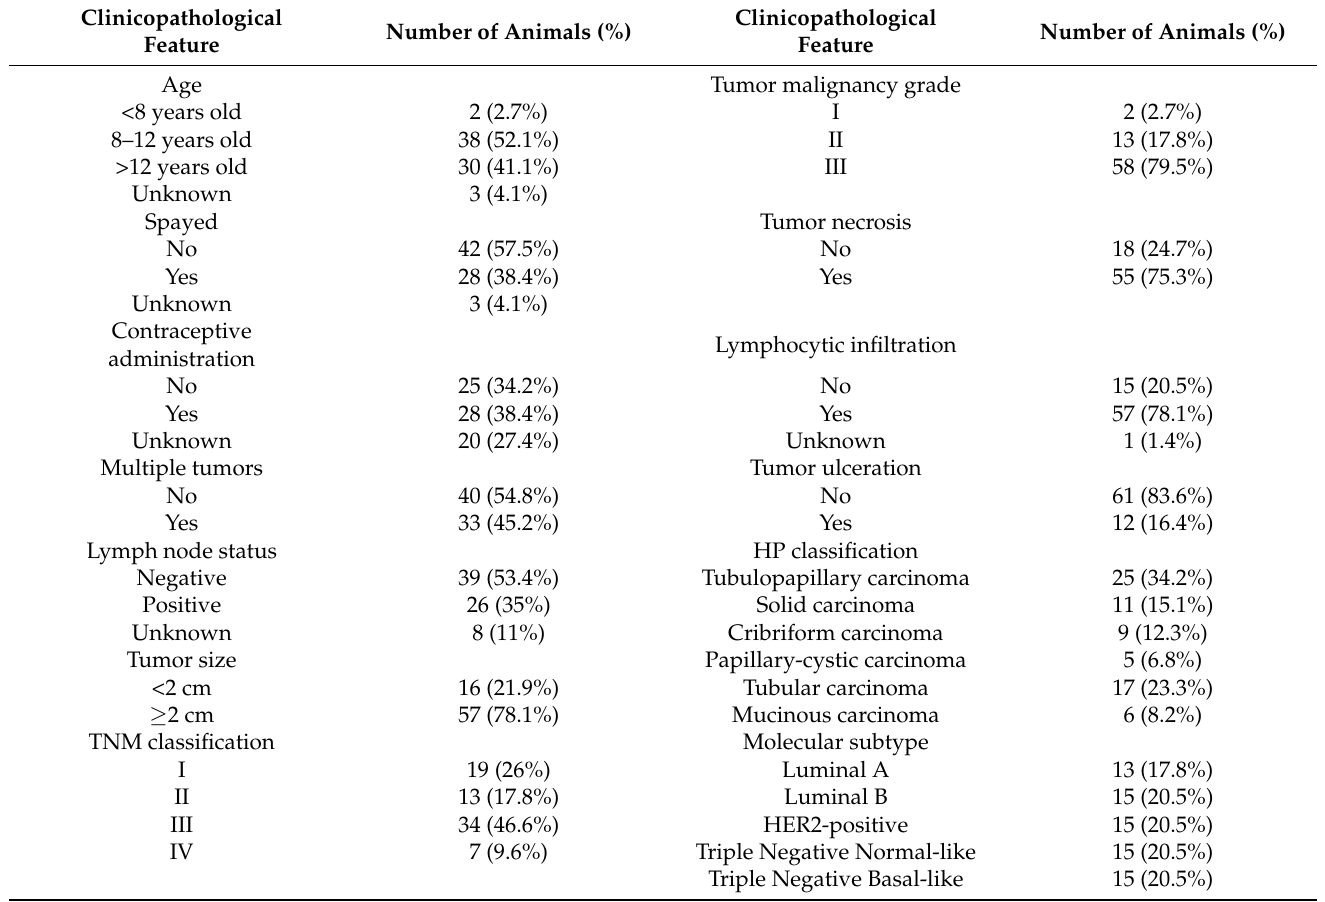
Table 1. None of the animals was excluded from the study. Table 1. Clinicopathological features of 73 cats with mammary carcinoma enrolled in this